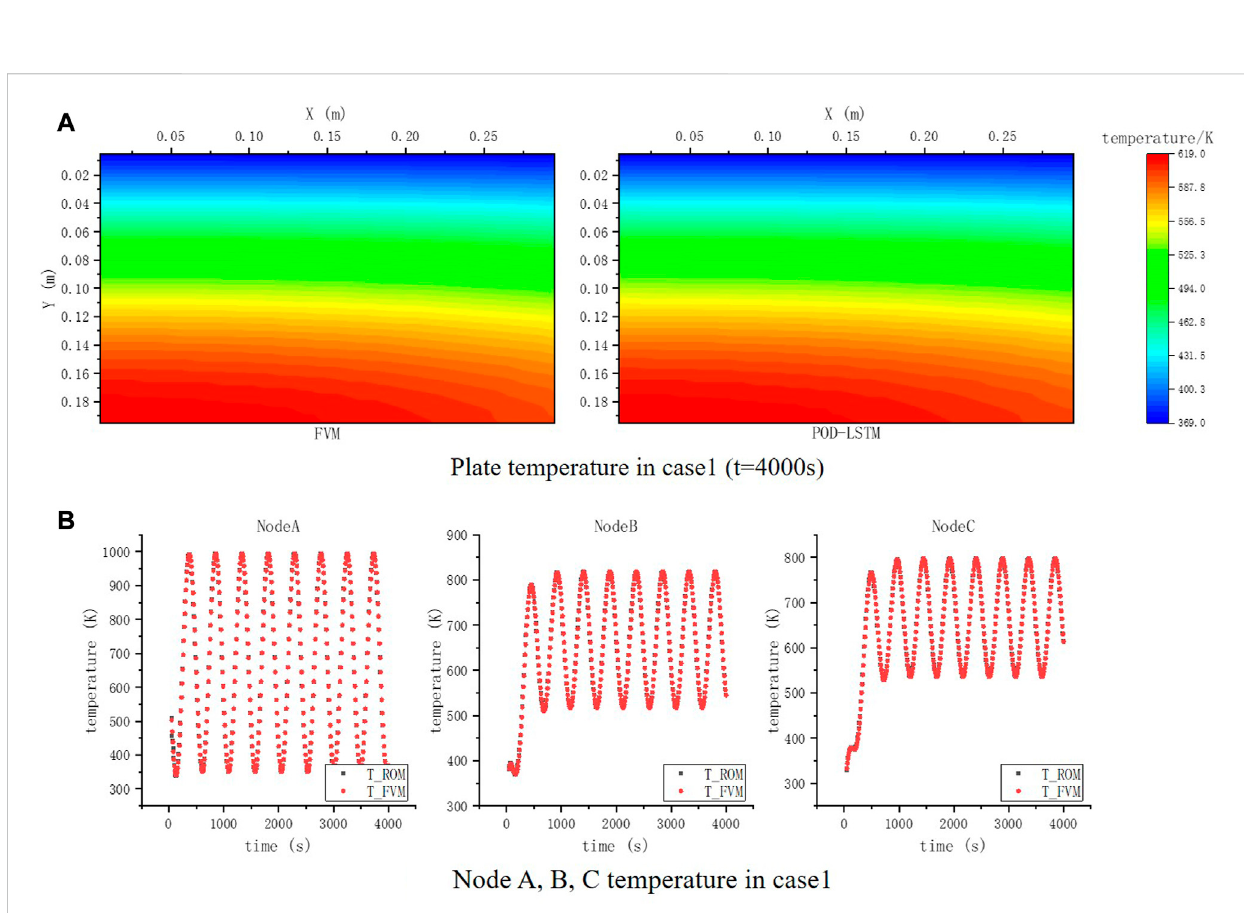
FIGURE 4 Temperature comparison in case 1. (A) Plate temperature in case 1 (t = 4,000 s). (B) Node A, B, and C temperature in case